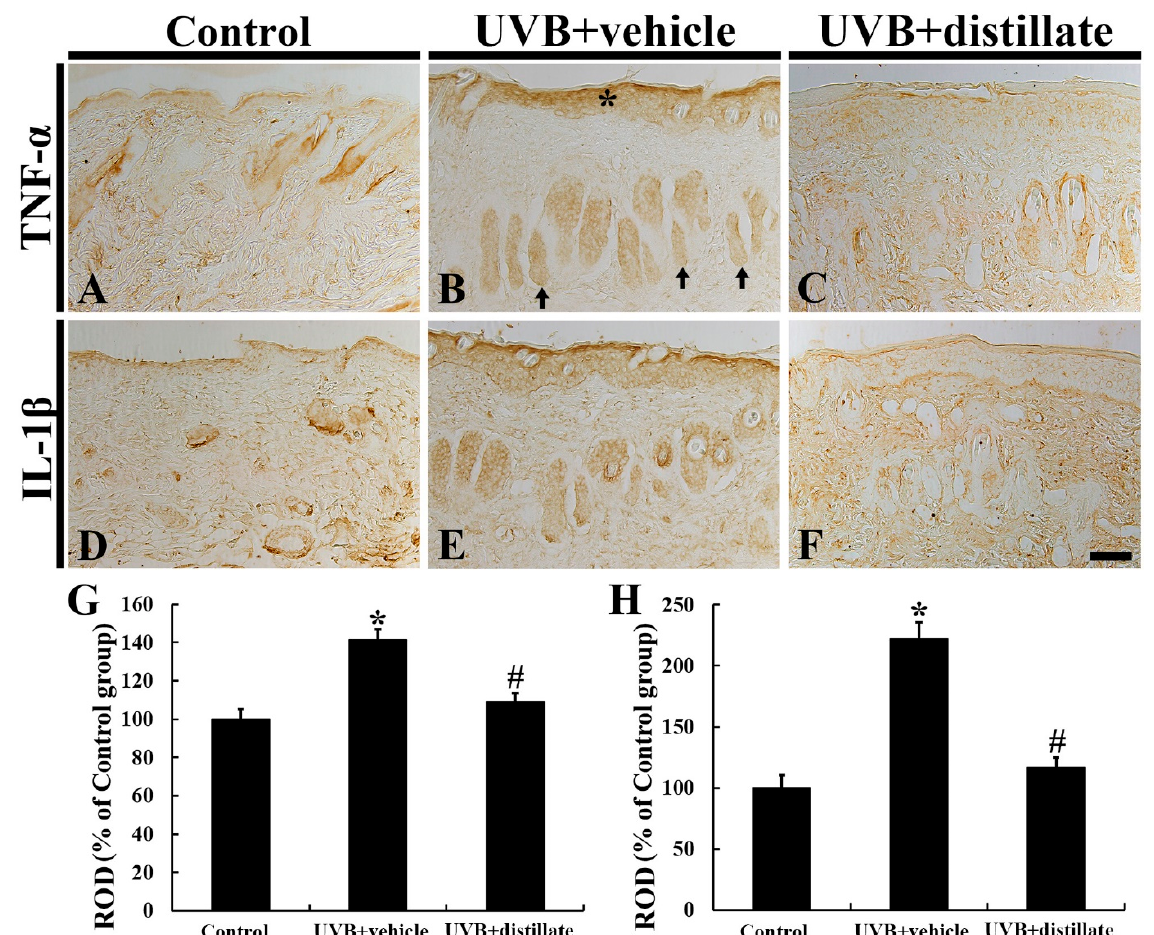
Figure 5. Tumor necrosis factor alpha (TNF- α ) ( A – C ) and interleukin (IL-1 β ) ( D – F ) immunohistochemistry in mouse dorsal skin in the control ( A , D ), UVB + vehicle ( B , E ), and UVB + distillate ( C , F ) groups at 5 days after UVB exposure. TNF- α and IL-1 β immunoreactivity in the UVB + vehicle group was significantly increased in the epidermis (asterisk) and hair follicles (arrows). However TNF- α and IL-1 β immunoreactivity in the UVB + distillate group was significantly reduced compared to that in the UVB + vehicle group. Scale bar = 100 μ m. ( G , H ) ROD of TNF- α ( G ) and IL-1 β ( H ) immunoreactivity in the dorsal skin as percentage of the control group. The data represent mean ± standard errors of means ( n = 10/group, * p < 0.05 vs. control group; # p < 0.05 vs. UVB + vehicle group).